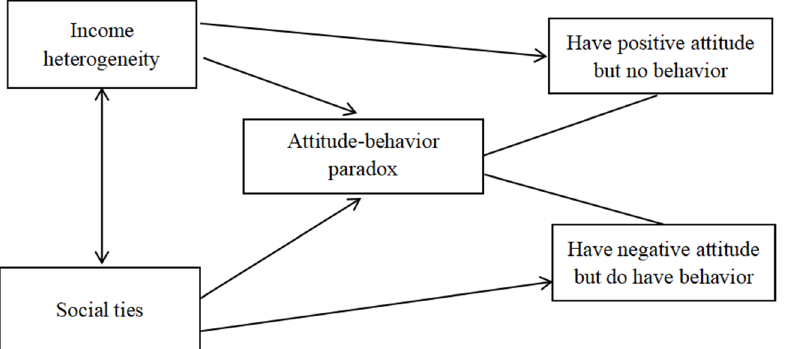
Figure 1. Conceptual framework of farmers’ attitude–behavior paradox.